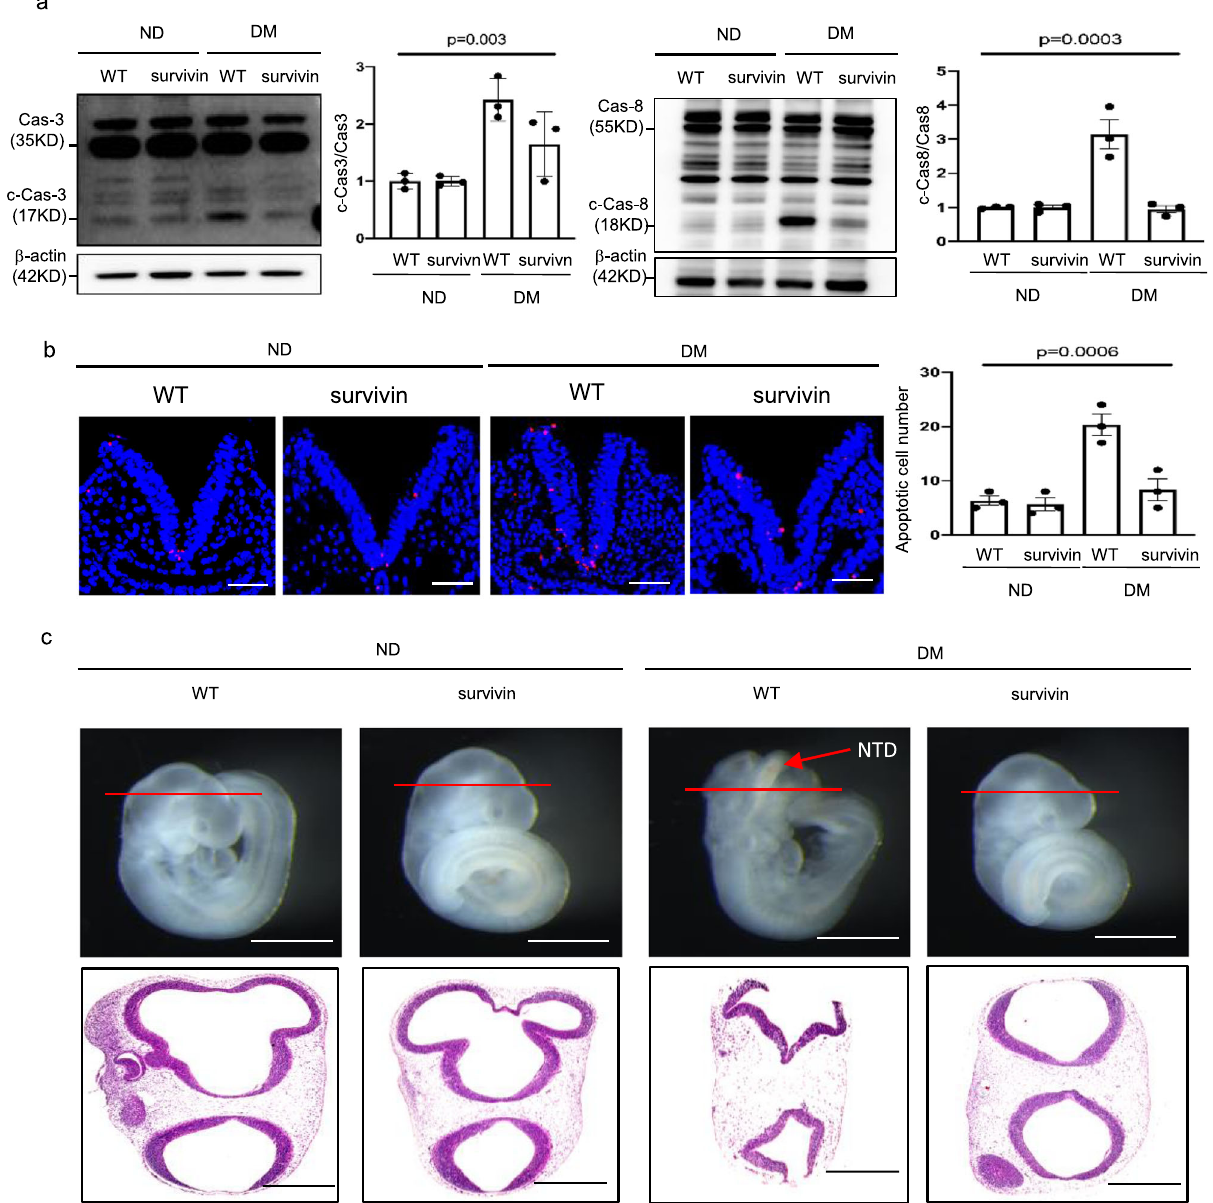
Fig. 6 Restoring Survivin expression in Flk-1 + progenitors reduces diabetes-induced apoptosis and NTD formation. a Protein levels of cleaved caspase 3 and caspase 8 in E8.5 embryos. b Representative TUNEL assay imaging showing apoptotic cells (red dots) in the E8.5 neuroepithelium and quanti fi cation of TUNEL-positive cell numbers in the bar graph. Cell nuclei were stained with DAPI (blue), bars = 30 μ m. c Representative imaging of WT and Survivin transgenic overexpressing embryos showing an NTD embryo with an open neural tube. Bars = 200 μ m and 100 μ m, for the top panel and the low panel, respectively. Experiments were performed using three embryos from three different dam per group ( n = 3). * indicates signi fi cant difference compared to other groups ( P < 0.05). ND nondiabetic, DM diabetes mellitus, WT wild type, Survivin Survivin transgenic overexpressing